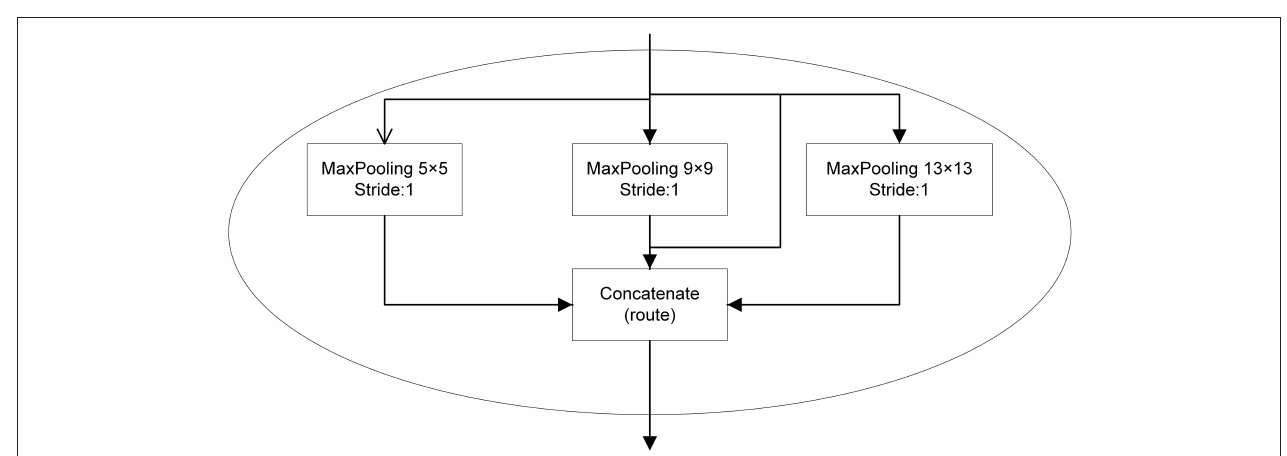
FIGURE 2 | The SPP structure in the improved YOLOv3 proposed in this work.